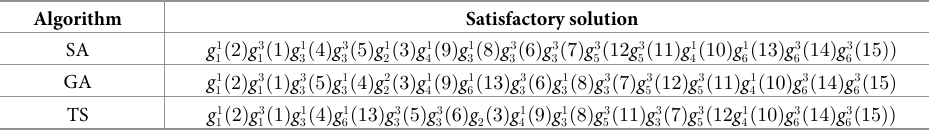
Table 5. Satisfactory operation plans obtained from the three algorithms.